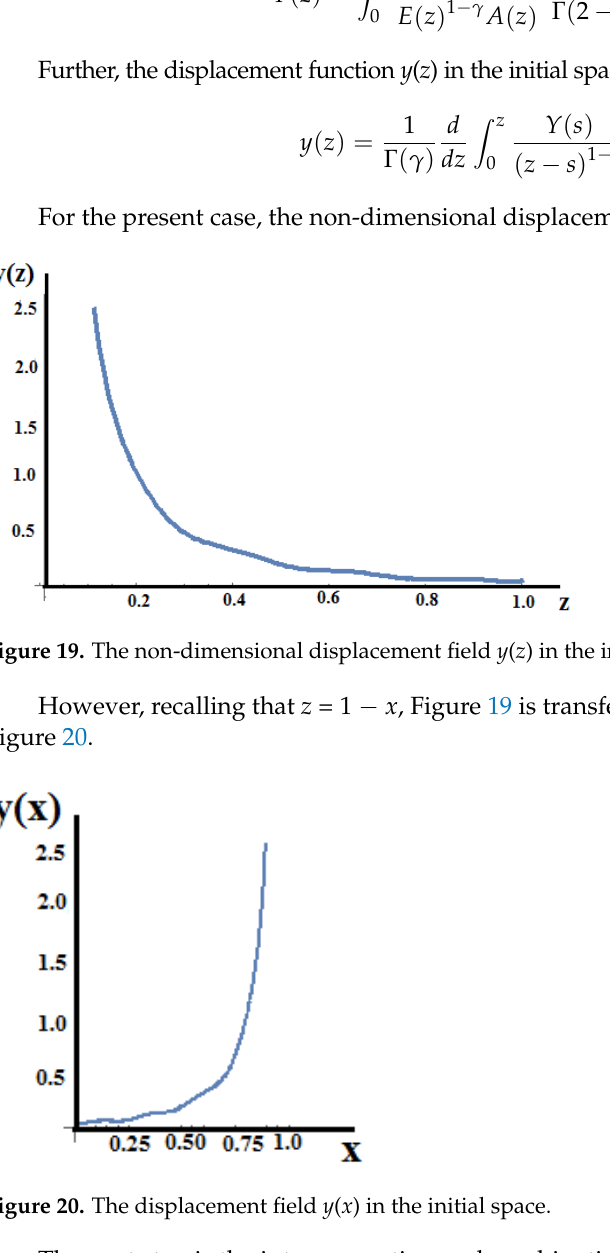
Figure 21. The distribution of the two side fractional stresses along the fractal bar.